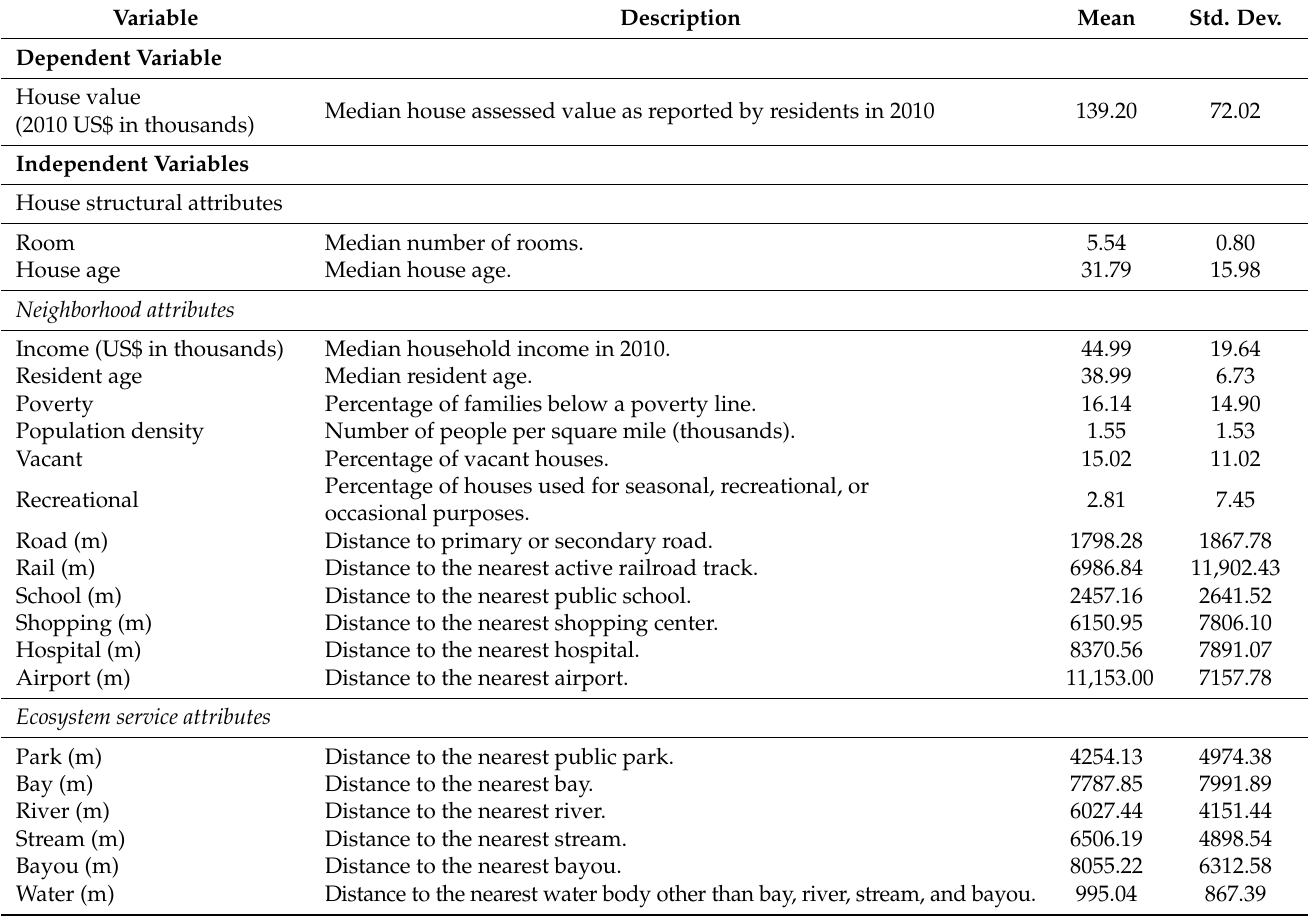
Table 1. Definition of variables used in the study to estimate a monetary value of distance to waterfront ecosystem services in coastal counties of Mississippi and Alabama,